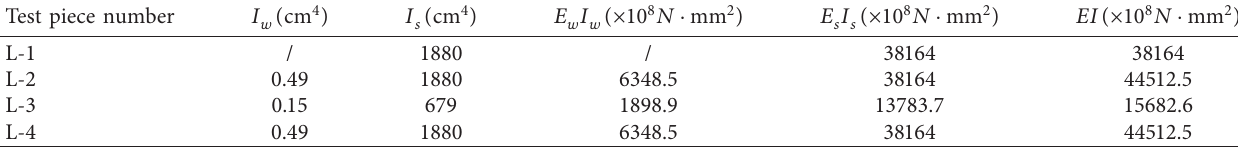
Table 4: Bending stiffness of composite beam.